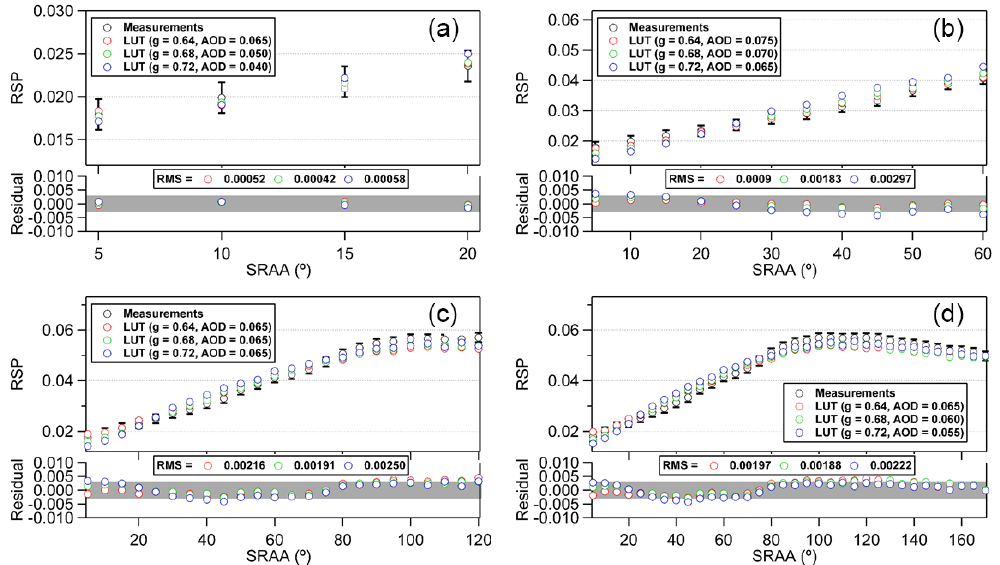
Figure 8. Comparison of measured RSP (black open circles) and simulated RSP (open circles) with the LUT using three different g (red: g = 0 . 64; green: g = 0 . 68; blue: g = 0 . 72). The examples shown here represent the best fit that minimizes Eq. (1) for different ranges of SRAA: (a) 5–20 ◦ , (b) 5–60 ◦ , (c) 5–120 ◦ , and (d) 5–170 ◦ SRAA. The retrieved AOD in each case is indicated in the